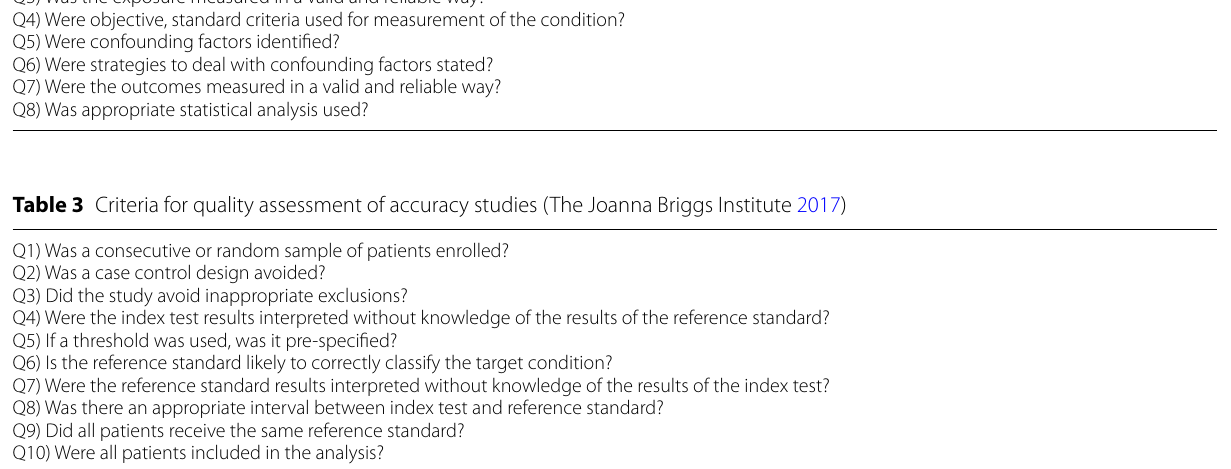
Table 2 Criteria for quality assessment of cross-sectional studies (The Joanna Briggs Institute 2020) Q1) Were the criteria for inclusion in the sample clearly defined? Q2) Were the study subjects and the setting described in detail? Q3) Was the exposure measured in a valid and reliable way? Q4) Were objective, standard criteria used for measurement of the condition? Q5) Were confounding factors identified? Q6) Were strategies to deal with confounding factors stated? Q7) Were the outcomes measured in a valid and reliable way? Q8) Was appropriate statistical analysis used?